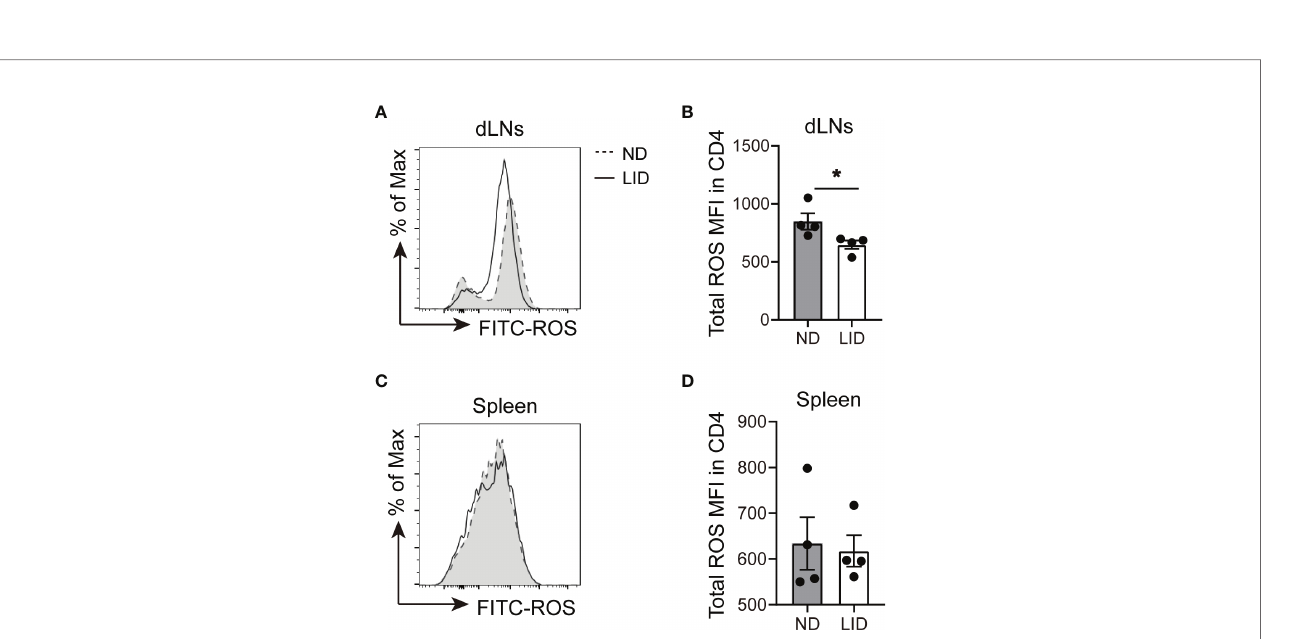
FIGURE 4 | Iron de fi ciency limits the production of ROS in CD4 + T cells. 3-weeks old female C57 mice were fed with ND or LID for 5 weeks and then were sacri fi ced for analysis. (A, B) Representative fl ow cytometry (A) and quanti fi cation (B) of total ROS in CD4 + T cells of dLNs after 5-weeks of LID treatment. (C, D) Representative fl ow cytometry (C) and quanti fi cation (D) of total ROS in CD4 + T cells of the spleen after 5-weeks of LID treatment. *P < 0.05 (unpaired two-tailed Student ’ s t -test for B, D ). Data are shown as mean ± S.E.M. Two independent experiments were performed, n =